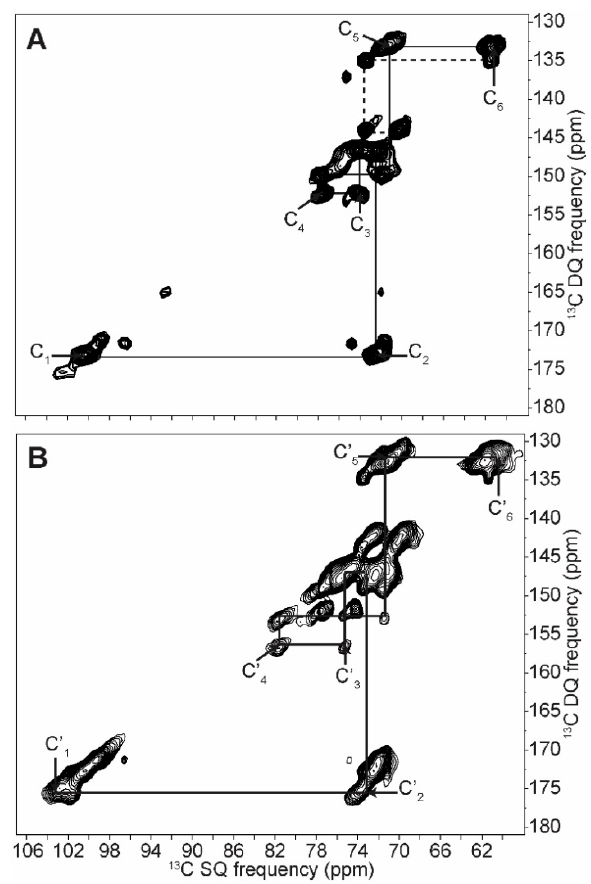
Figure 5. NOE ( A ) and CP (cross ‐ polarization) ( B ) INADEQUATE 13 C solid ‐ state NMR spectra of native C. reinhardtii A ‐ type starch. Continuous lines link correlated spins in crystalline ( A ) and amorphous ( B ) regions, while dashed lines correspond to non ‐ reducing end groups.